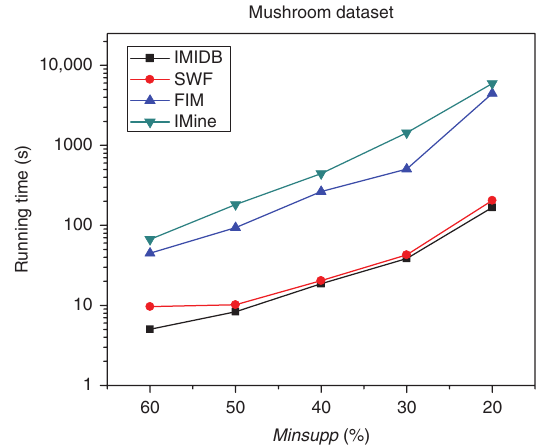
Figure 8: Running Time Comparison – Mushroom Dataset.